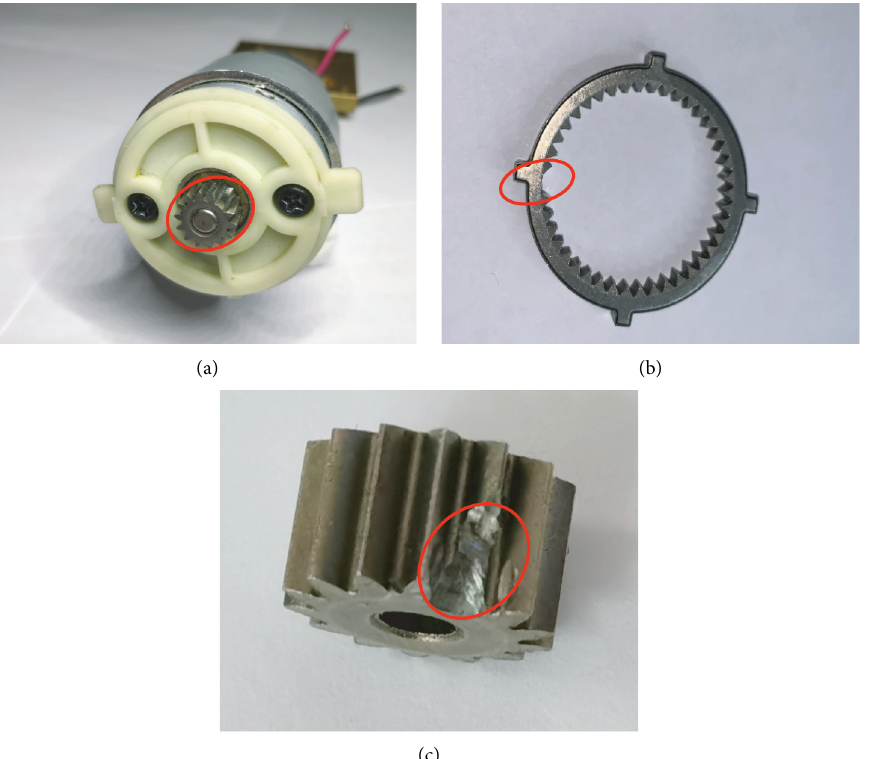
Figure 3: (a) EID with a faulty sun gear connecting the motor and gearbox; (b) EID with a faulty ring gear; (c) EID with a faulty planet gear. Faults are highlighted in the red ovals.